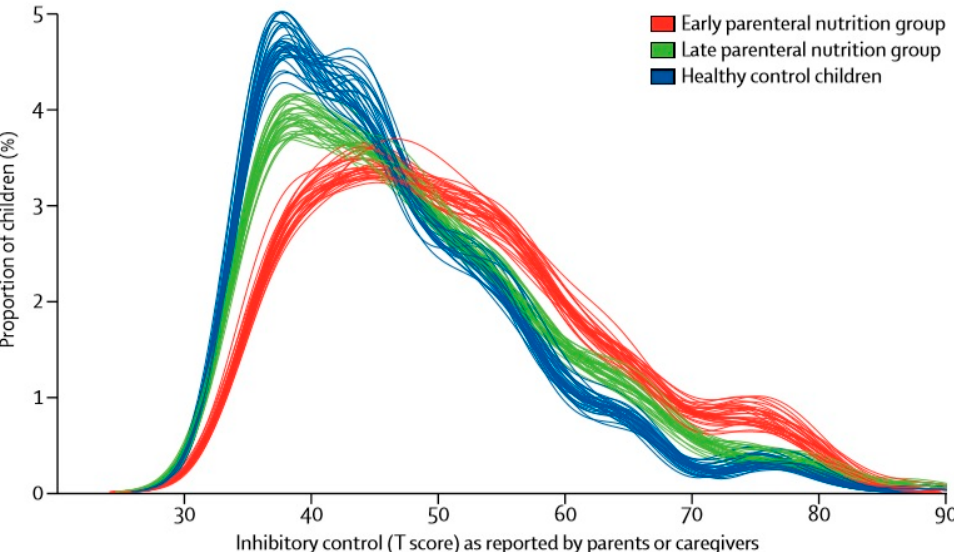
Figure 2. Density estimates for inhibitory function as reported by parents or caregivers. Densities, which correspond to the proportions of children with a certain score (equivalent to a smoothed histogram), are shown separately for healthy control children and for PEPaNIC participants who were randomly assigned to receive late PN or early PN. Higher scores indicate worse functioning. Each line corresponds to one of 31 imputed datasets. Figure reprinted from [53] with permission from Elsevier.